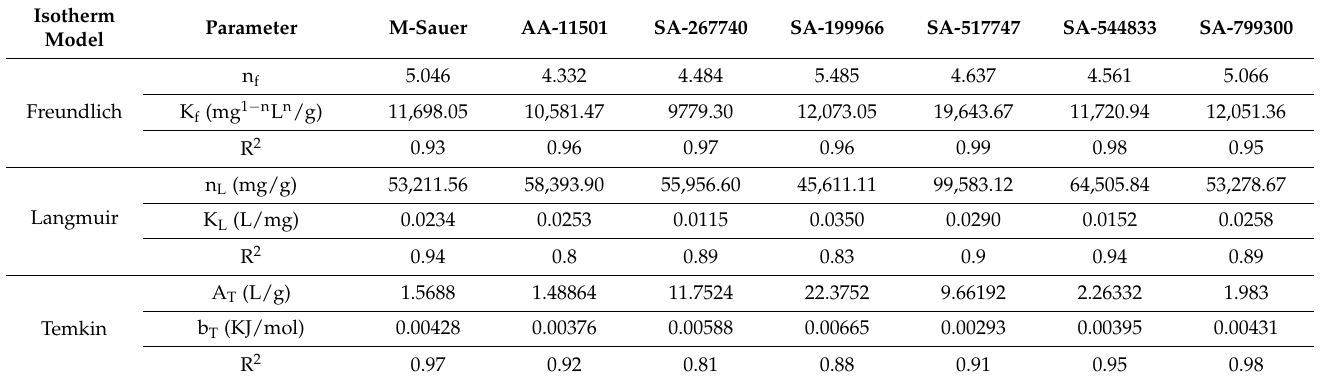
Figure 3. Adsorption isotherms: ( a ) Freundlich, ( b ) Langmuir, and ( c ) Temkin of CA-99Mo on different alumina adsorbents. Table 2. Isotherm parameters calculations for the adsorption of carrier-added 99 Mo on different alumina